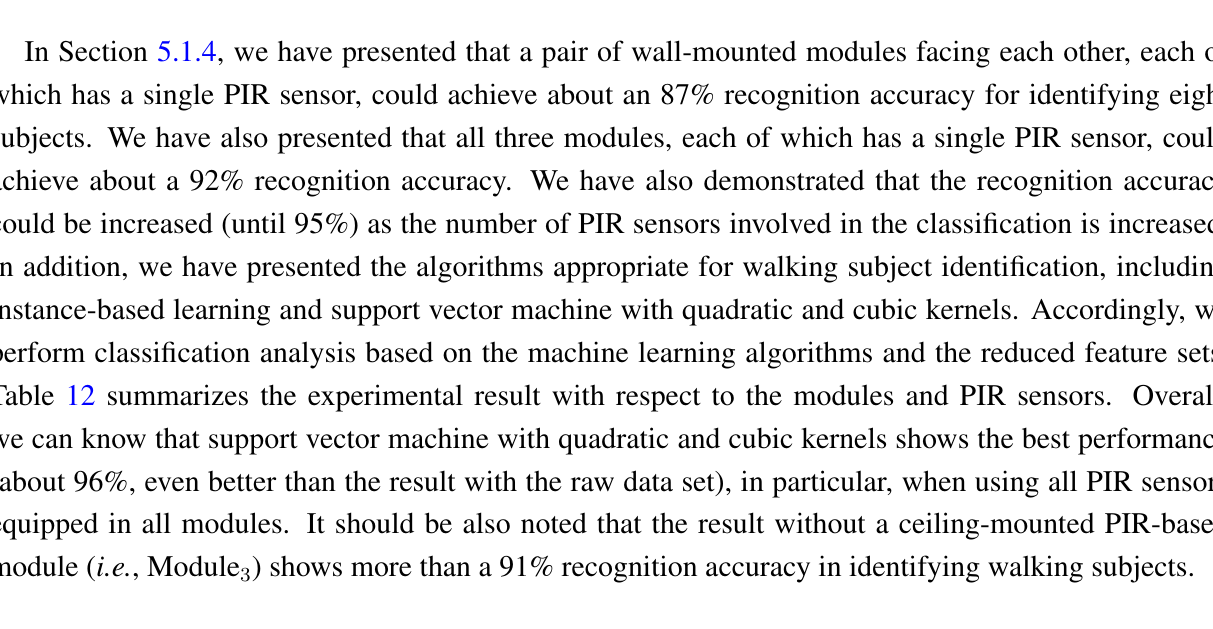
Table 12. Comparison of the recognition accuracy (%) of identifying walking subjects based on the reduced feature set with respect to the modules and PIR